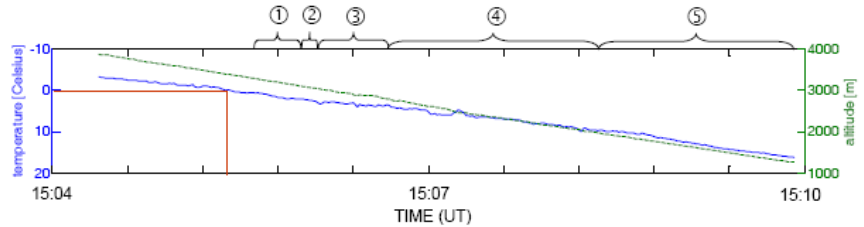
Fig. 10. Atmospheric temperature (blue line) and aircraft altitude (green line) in the time interval 15:04–15:10UTC as measured by the in- Figure 10. Atmospheric temperature and aircraft altitude in the time interval 15:04-15:10 818 situ sensor (Gerber PMV100) on-board the ATR42 SAFIRE. The figure also identifies five distinct time intervals characterized by different UTC as measured by the in-situ 2D-C probe on-board the ATR42 SAFIRE. The figure also 819 precipitating particle types and properties, which are discussed in detail in Figs. 11 and 12. identifies five distinct time intervals characterized by different precipitating particle types 820 and properties, which are discussed in detail in figures 11 and 12. 821 822